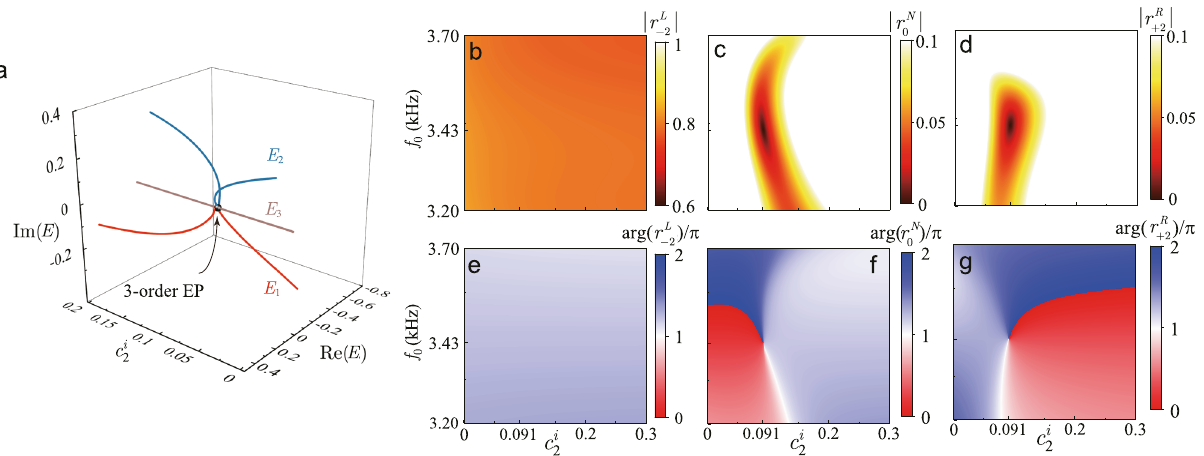
Fig. 3 Eigenvalue and re fl ection coef fi cient distribution near the third-order exceptional point (EP). a Variation of trajectories of the eigenvalues as functions of c i (normalized imaginary part of the sound speed in the second groove). E 1 , E 2 and E 3 represent the three theoretically calculated eigenvalues, 2 with the corresponding curves marked by different colors. The gray globe in the center represents the third-order EP. Calculated amplitude of retro- ; r N ; r R re fl ection coef fi cients, r L , as functions of f 0 (working frequency) and c i (cid:3) 2 0 þ 2